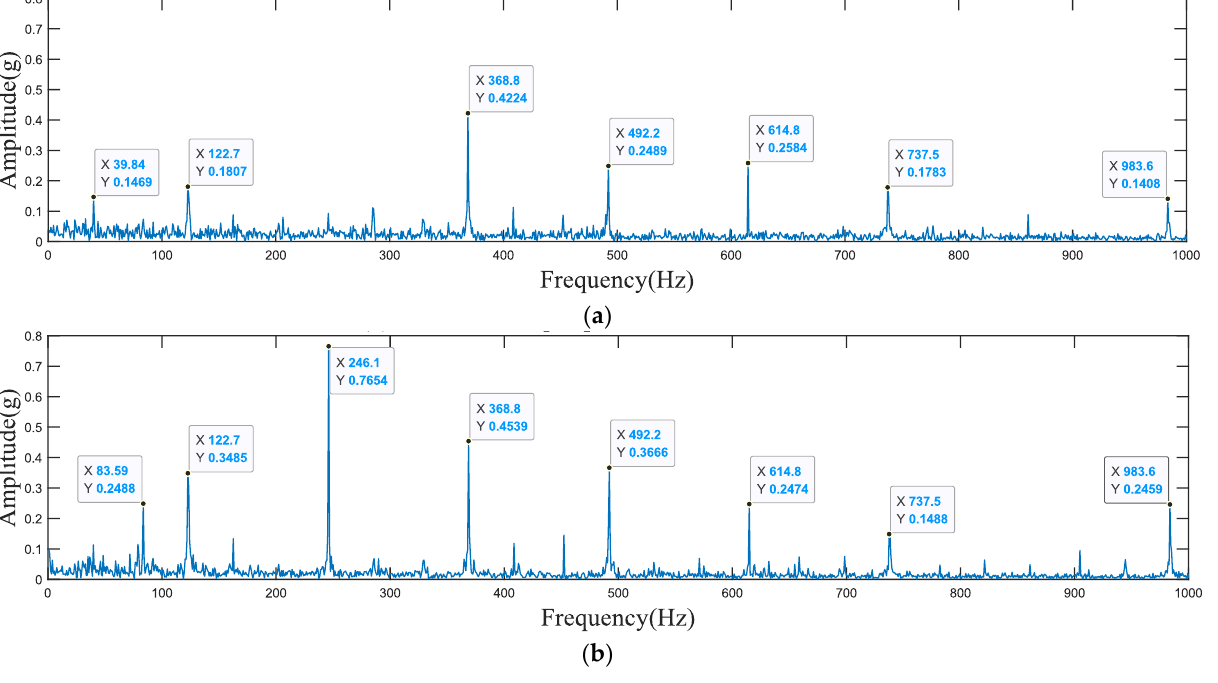
Figure 9. Hilbert-envelope spectrum: ( a ) Hilbert-envelope spectrum of horizontal direction; ( b ) Hilbert-envelope spectrum of vertical direction.